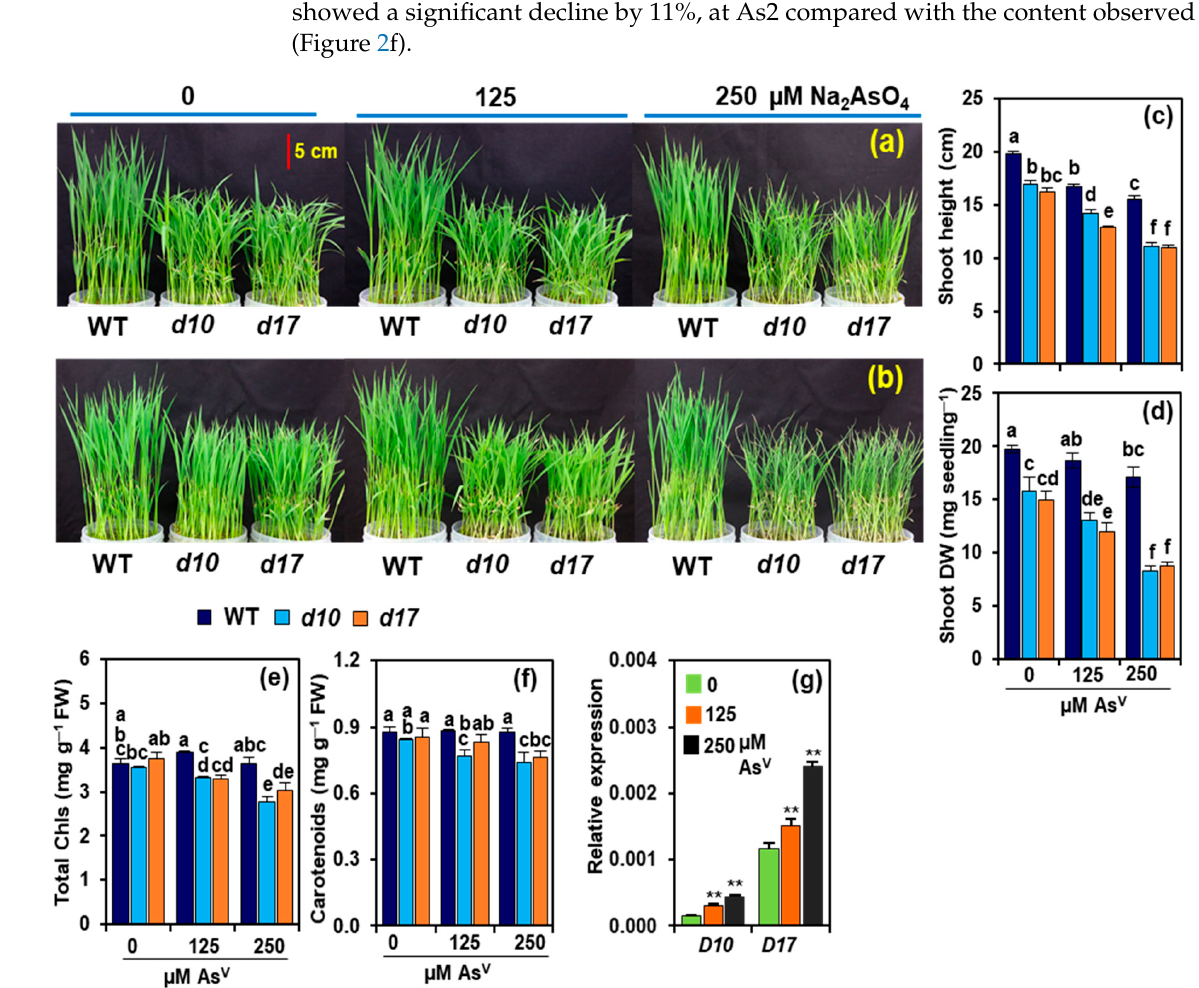
Figure 2. ( a – f ) Growth-related features of wild-type (WT) and d10 and d17 mutant plants exposed to different concentrations of sodium arsenate (Na 2 AsO 4 ; 0, 125 and 250 μ M As V ). Shoot phenotypes were recorded on day 3 ( a ) and day 5 ( b ) of As V treatments. Shoot height ( c ), shoot dry weight ( d ), and the levels of total chlorophylls ( e ) and carotenoids ( f ) were assessed on day 5 of As V treatments. ( g ) Relative expression of D10 and D17 genes was examined in the shoots of WT on day 3 of As V treatments. Represented numerical data are the means with standard errors ( n = 4 biological repeats). Significant differences ( p < 0.05) among the treatments are denoted by distinct alphabetical letters according to a least significant difference test. Student’s t -test (** p < 0.01) was conducted to identify significant variations among 0, 125 and 250 µ M As V treatments ( g ). Chls, chlorophylls; DW, dry weight; FW, fresh